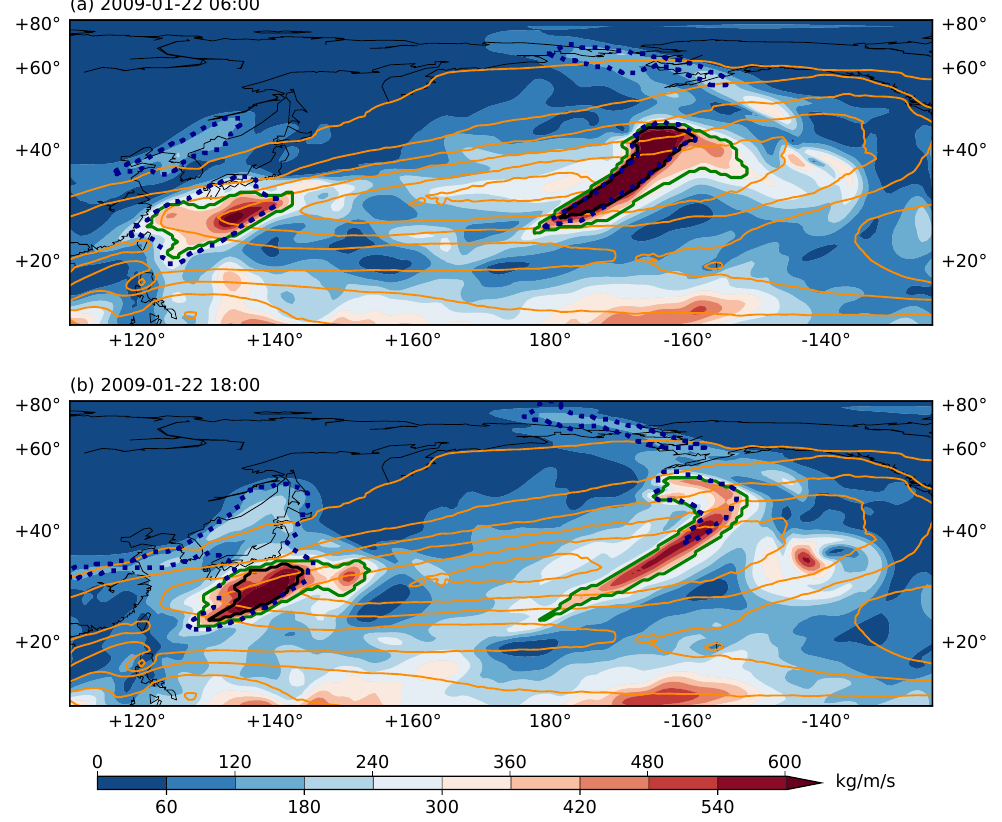
Figure 2. IVT distributions (in kg/m/s) at the time of ( a ) 22 January 2009 06 UTC and ( b ) 22 January 2009 18 UTC over the North Pacific. ARs identified by the THR method are drawn in green contours, those by the IVT250ano method solid black contours, and those by the IVT85% method dashed black contours. Hatching indicates the regions where the IVT anomalies are above the 250 kg/m/s threshold. Orange contours are the contours of the 85th IVT percentile of the month January 2009. Contours have an interval of 100 kg/m/s. Only the pattern is shown, and the labelling of these contours are omitted for